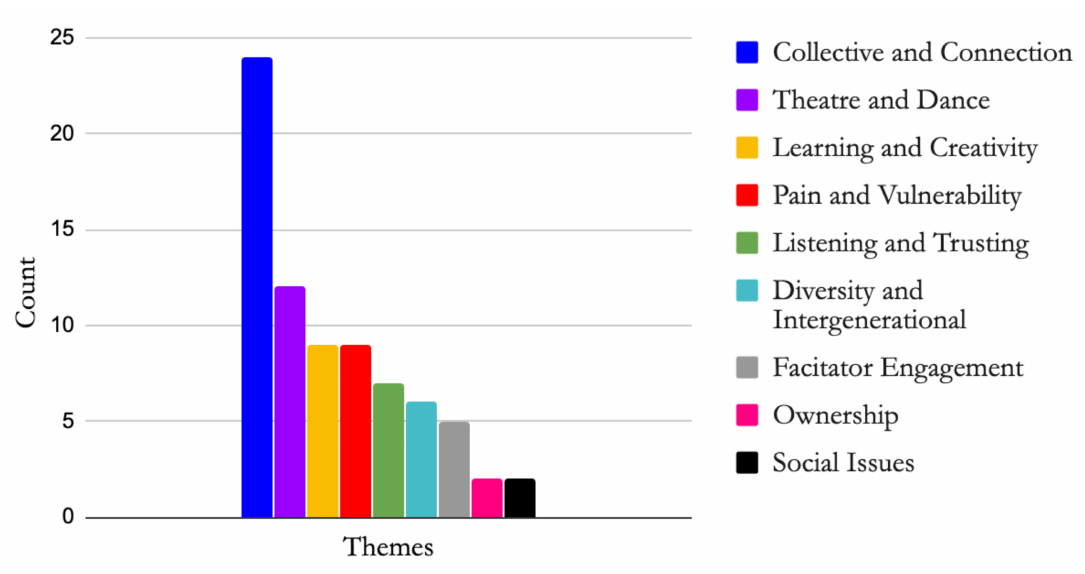
Figure 3. Themes from the Lopez Island Story